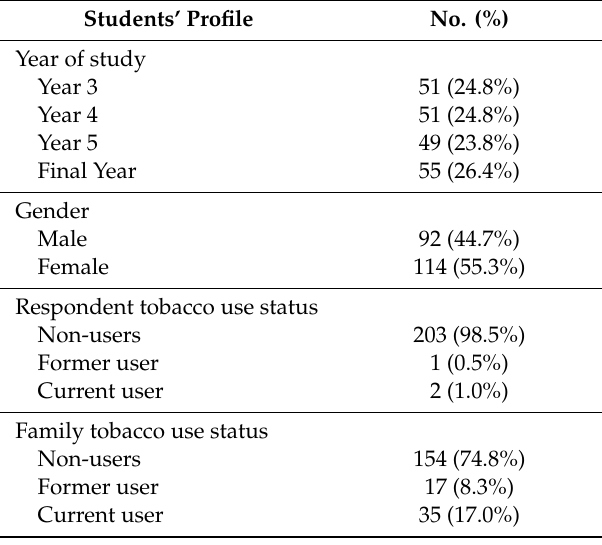
Table 1. Students’ demographic profile, their families’ and their tobacco use status ( n =